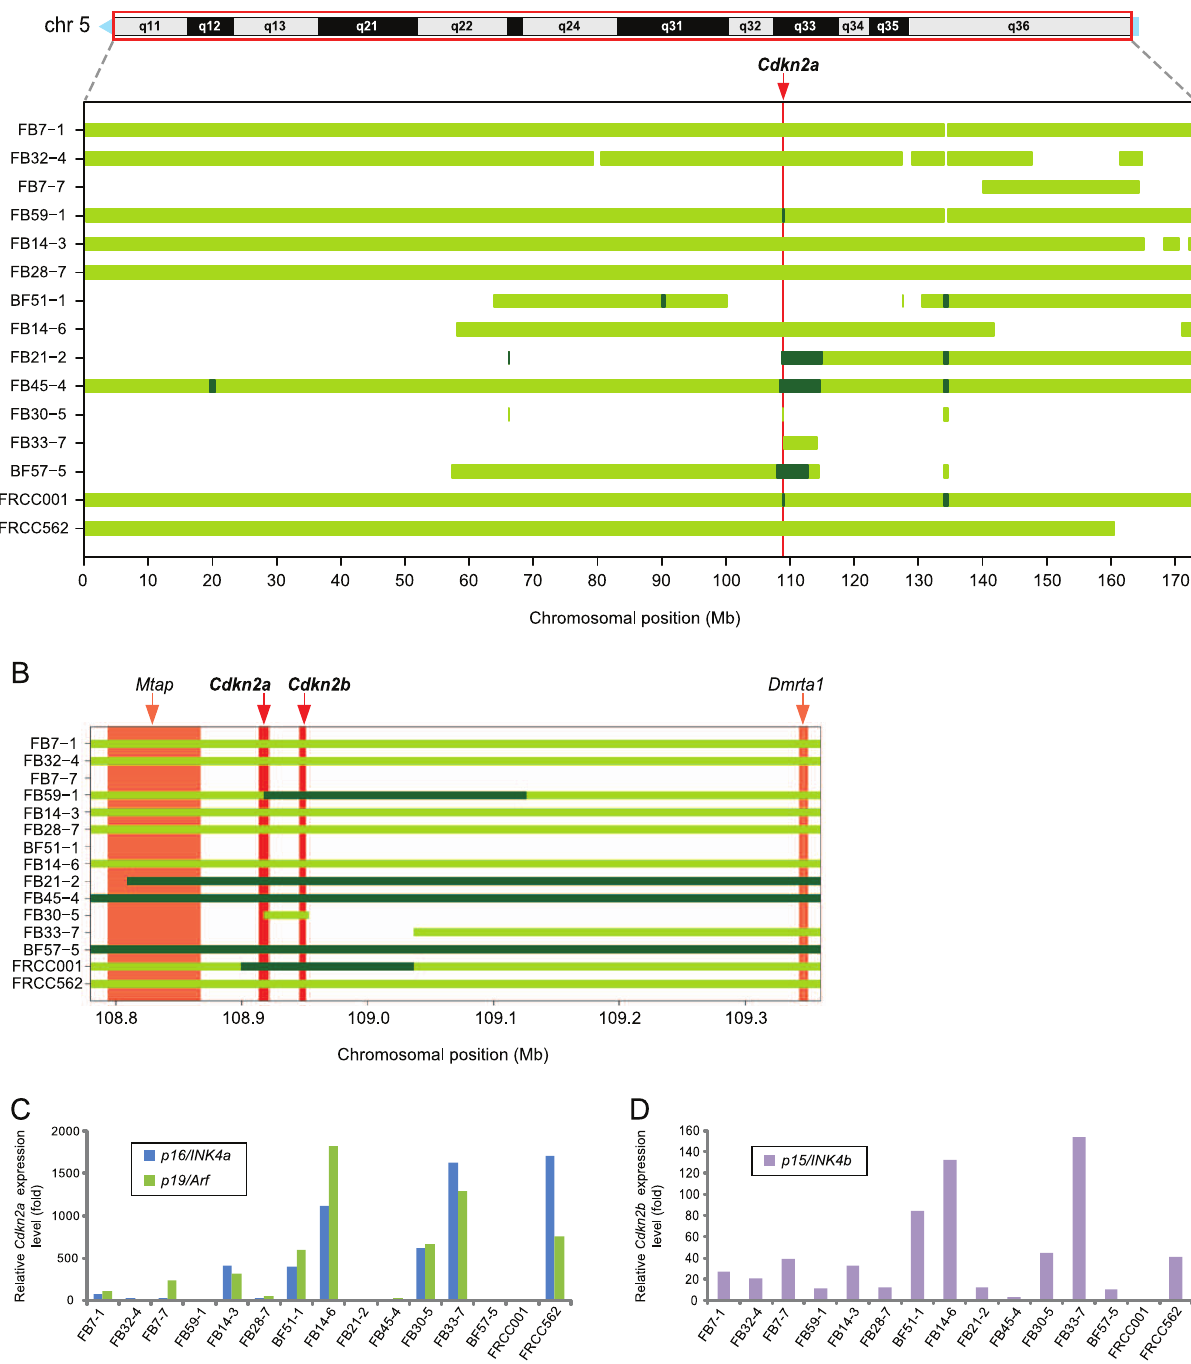
PLOS ONE | www.plosone.org 4 August 2012 | Volume 7 | Issue 8 |